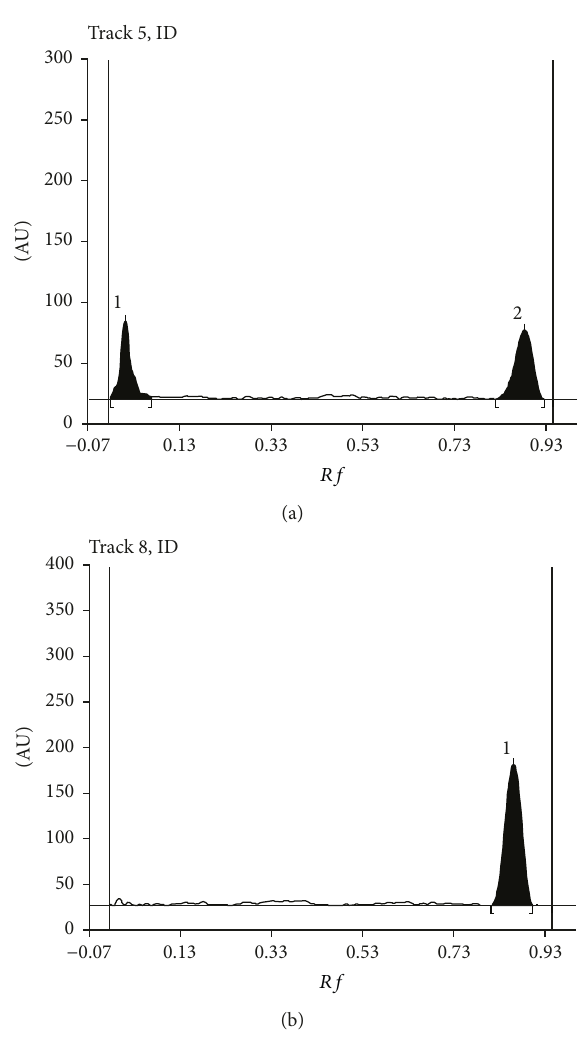
Figure 3: Densitograms of diphenhydramine after 50 h of exposure to UV light (a) and after 50 h of heating (b), 𝜆 0.82 (a), 𝑅 = 0.81 𝐹